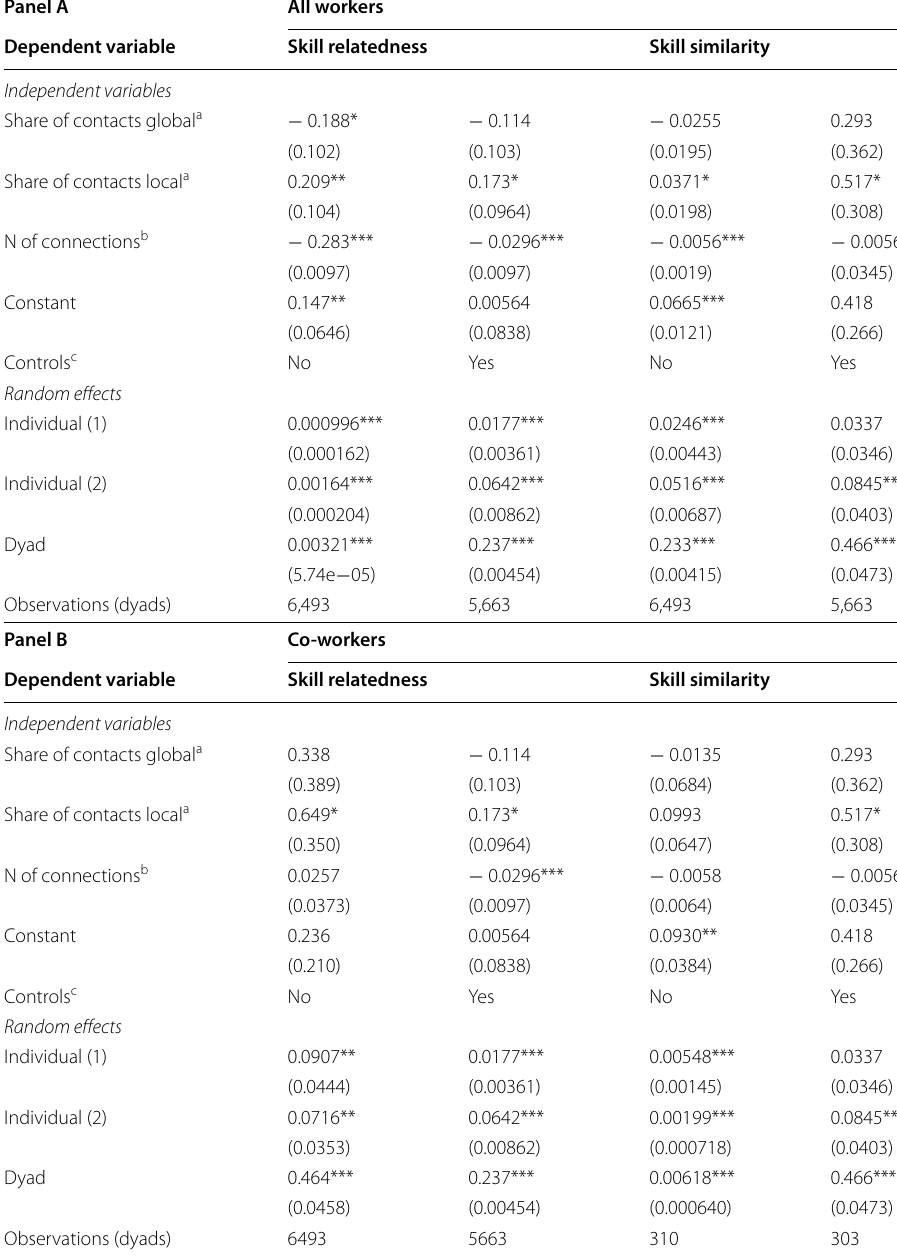
Table 3 The relationship between geography of networks and skill relatedness and skill